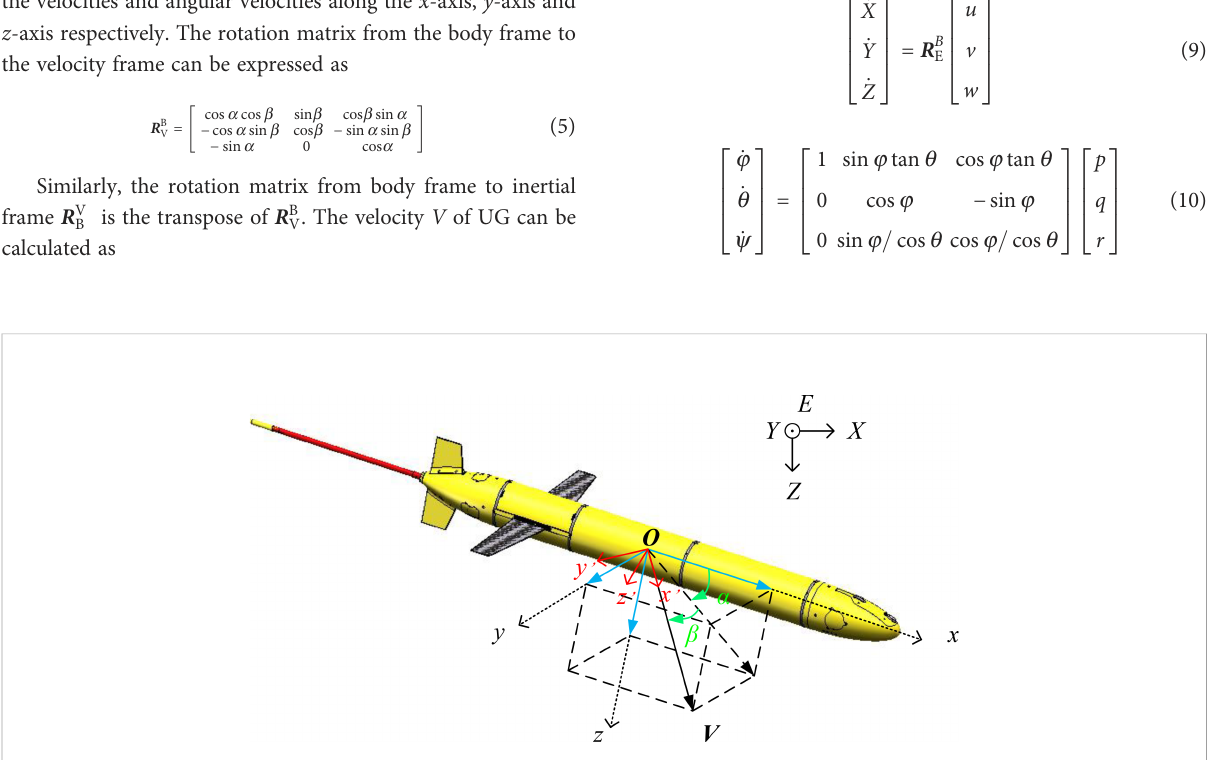
FIGURE 5 Coordinate frames of